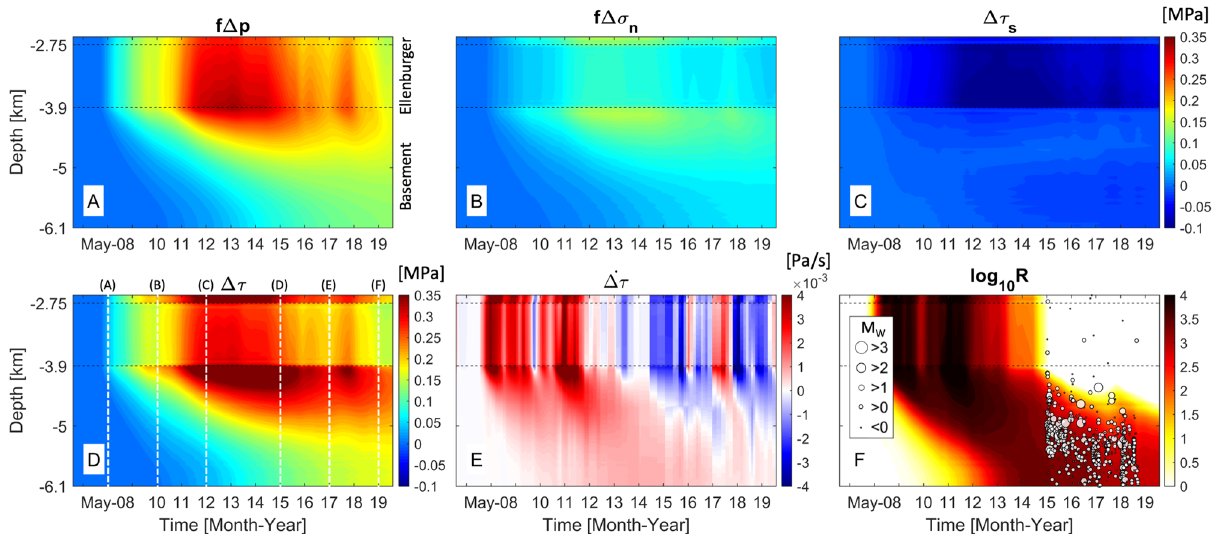
Figure 3. Spatio-temporal distribution of changes in Coulomb stress components ( A – C ), total Coulomb stress ( D ), time derivative of Coulomb stress change ( E ), and seismicity rate in base 10 logarithmic scale ( F ) along the fault line indicated as an orange dash line in Fig. 2E. White dash lines in Fig. 3D indicate time steps of the serial results shown in Fig. 4. The earthquake catalogs are fitted to the seismicity rate ( log 10 R ) and the magnitude of earthquakes varies with size of circles.